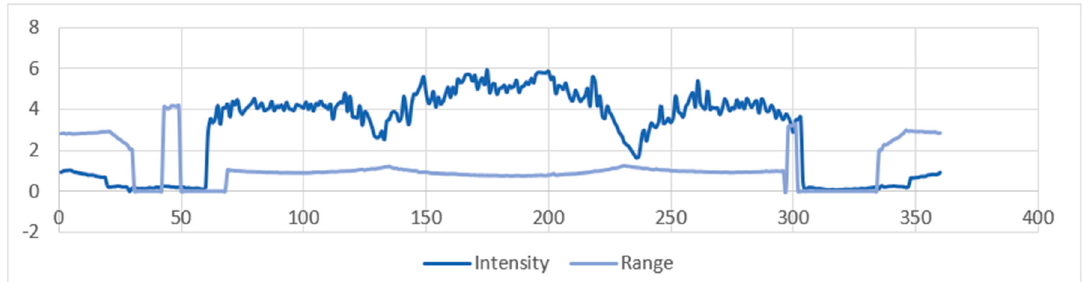
Figure 19. The 360 received intensity laser scan points mapped linearly for the Figure 18.